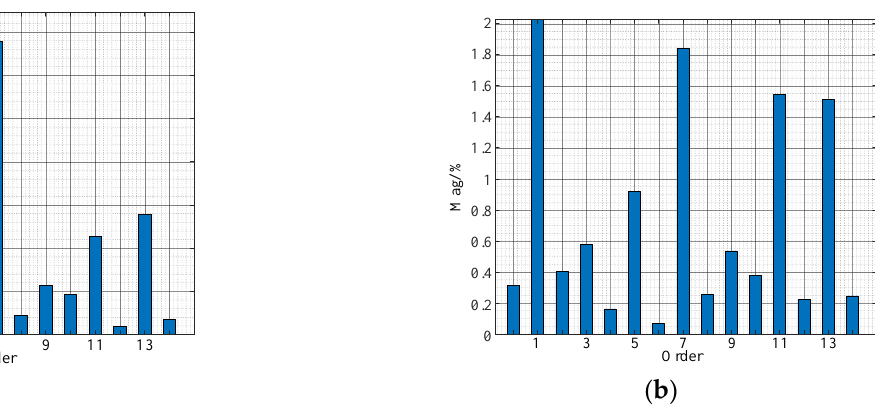
Figure 19. The FFT analysis results of the stator current under different resonant controllers. ( a ) G R ( s )